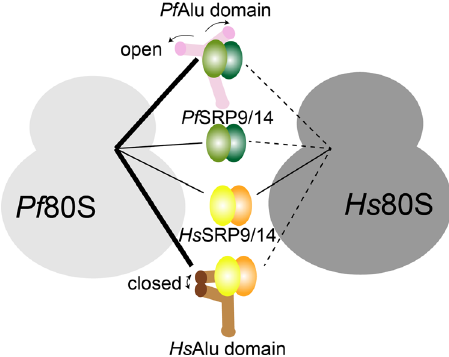
Fig. 8 Model of SRP Alu domain – ribosome interactions. Schematic diagram outlining the Pf and Hs Alu domain – ribosome interactions. Dashed lines indicate weak µ M binding, thin solid lines weak nM binding, and thick solid lines indicate strong nM binding. The open and closed conformations of the Alu domain are